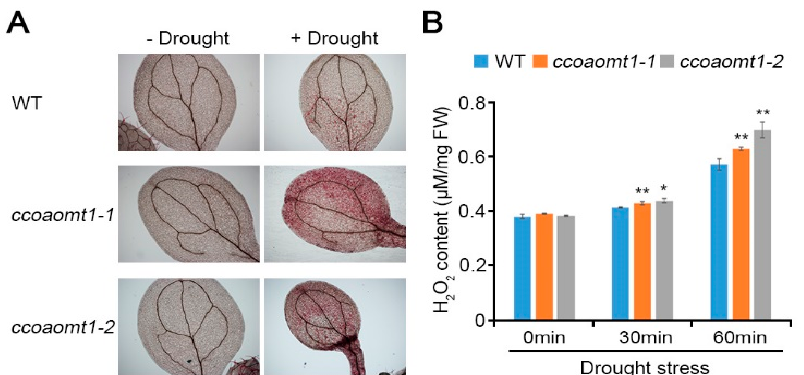
Figure 4. H 2 O 2 accumulation in ccoaomt1 mutants by drought stress. ( A ) DAB staining of drought- stressed leaves. The leaves of 10-day-old seedlings of WT and ccoaomt1 mutants were stained with 3,3 ′ -Diaminobenzidine (DAB) before and after drought stress (for 60 min). The red color represents insoluble ROS products, which hydrogen peroxide (H 2 O 2 ) reacts with DAB. ( B ) Quantified H 2 O 2 content. Internal H 2 O 2 production assays were performed using WT and ccoaomt1 mutants and the fluorescence intensity was measured with the range excitation at 530 nm and emission at 590 nm. The quantitative values indicated means ± SD of three independent experiments. Asterisks repre- sent significant differences from the WT (*, p < 0.05; **, p < 0.01; Student’s t -test).